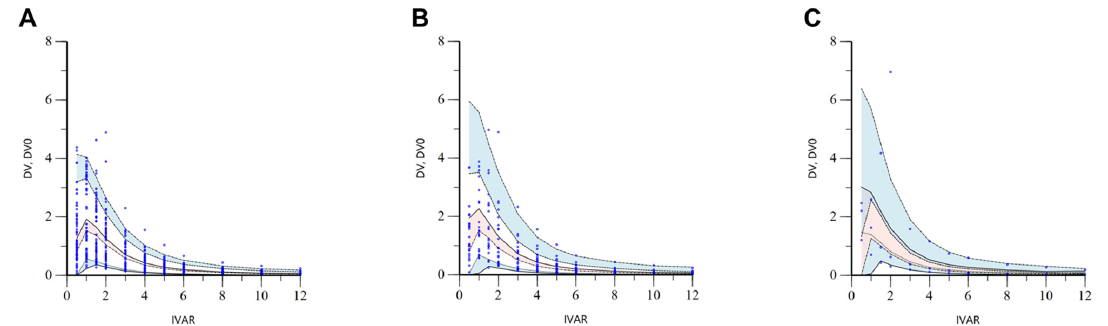
Figure 6. Stratified VPC results by ET ( A ), IT ( B ), and PT ( C ) phenotypes of OATP1B1 for the final torsemide Pop-PK model. The dots on the graph represent observations. The black dashed lines mean the 95th, 50th, and 5th percentiles of predicted concentrations, respectively. Blue shaded areas mean 95% CIs for the predicted 95th and 5th percentiles. Red shaded area means 95% CI for the predicted 50th percentile. IVAR ( X -axis) means the time after oral torsemide administration. DV and DV0 ( Y -axis) are observed concentrations of torsemide in the serum and concentrations predicted by the model, respectively.